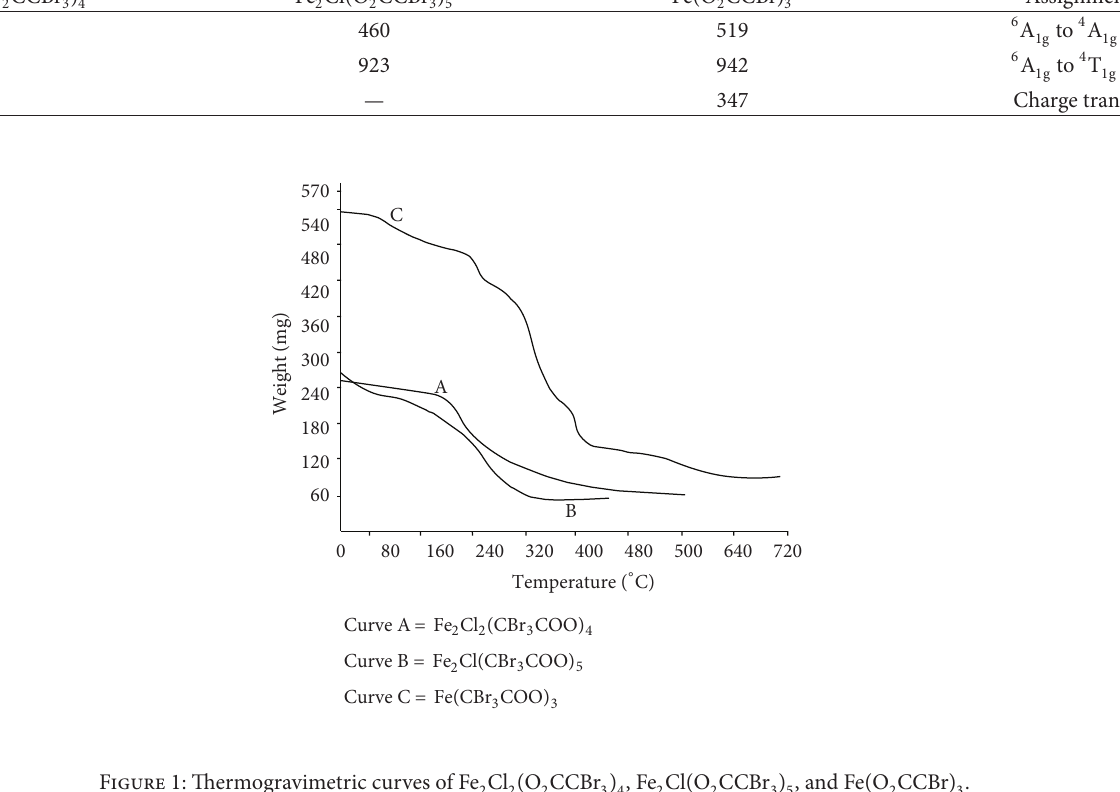
F 1: ermogravimetric curves of